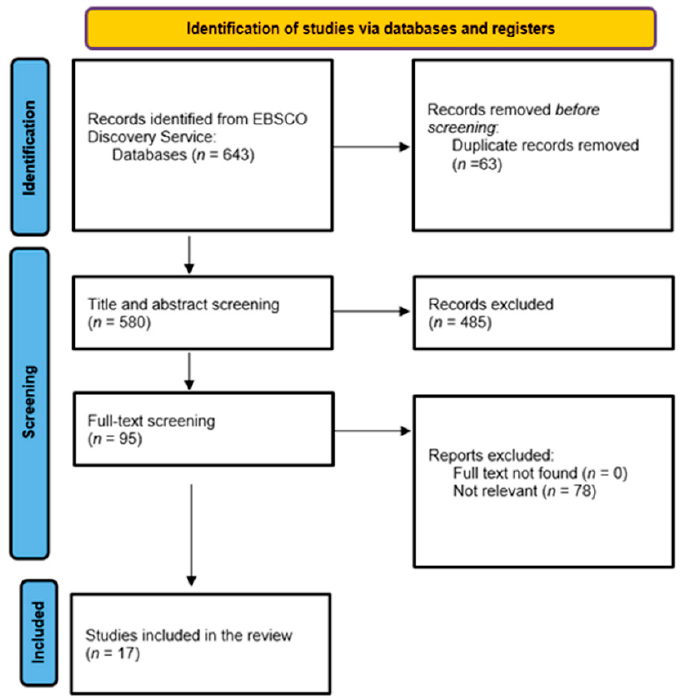
Figure 1. Preferred Reporting Items for Systematic Reviews and Meta-Analyses (PRISMA) diagram.